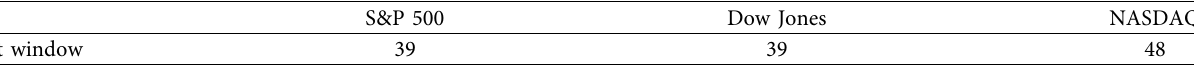
Table 8: Best window length to maximize the log likelihood when the test set is 10%.